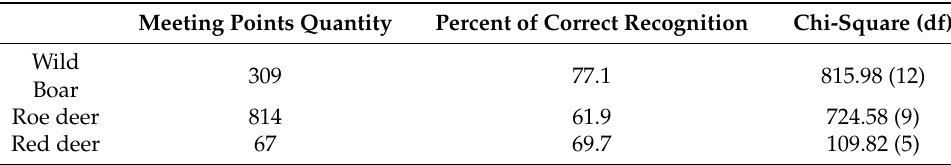
Table 6. Main discriminant analysis results for main prey species.